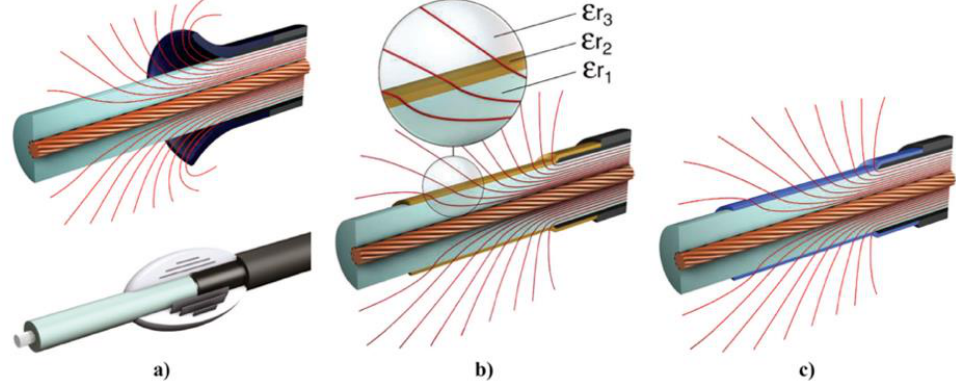
Figure 3. Various technologies used for stress control in cable termination: ( a ) Geometric stress control (up) with conductive layers (down), ( b ) refractive stress control (insulation ( 𝜀 𝑟 ), control ( 𝜀 𝑟 ), and surrounding ( 𝜀 𝑟 ) materials), and ( c ) impedance stress control. © 2021 IEEE. Reprinted, with permission from [22].